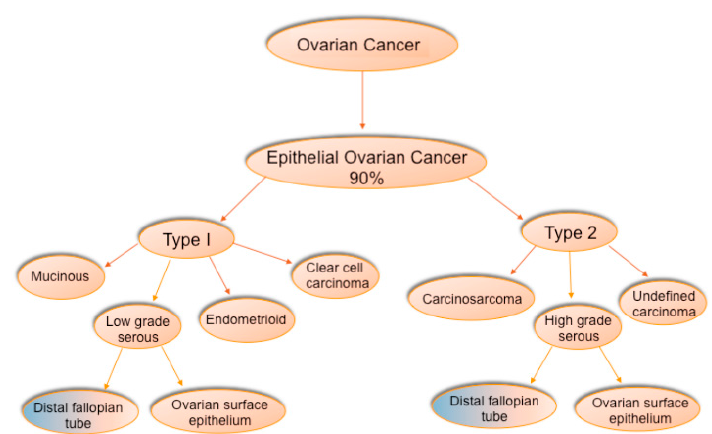
Figure 1. Classification of the Epithelial Ovarian Cancer histological subtype according to the two tier system. Type I tumors include endometroid, clear cell carcinoma, mucinous, and low grade serous. Type II tumors are mostly comprised of high grade serous but also include carcinosarcoma and undefined carcinomas [5,15,18,20].